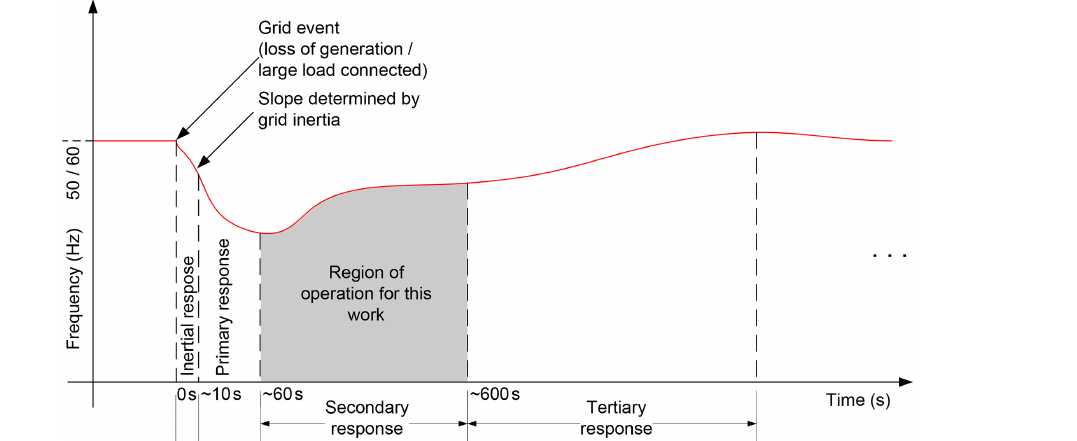
Figure 1. Grid frequency response to a sudden load increase or loss of generation. Region of secondary frequency regulation shown